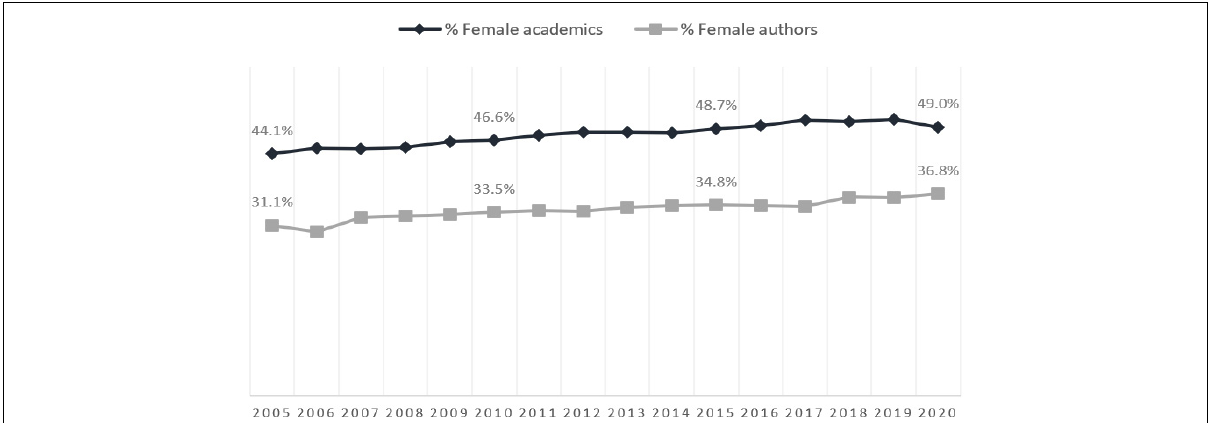
Figure 1: Women’s proportional share among academics is consistently higher than their share among authors, although both have increased by 5% from 2005 to 2020. Table 1: Authorship-staff (FTE) ratio by gender and race, and changes over time from 2005 to 2020